Question: Express in one sentence what the figure is showing.
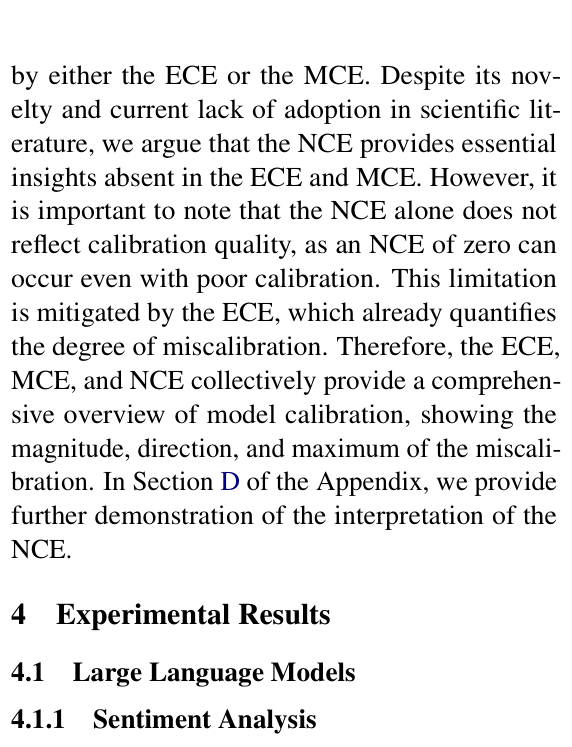
Answer: Calibration plots and confidence histograms for the sentiment analysis task with binary labels. GPT- 3.5 shows closer calibration to the ideal, whereas the other models mostly exhibit underconfidence.